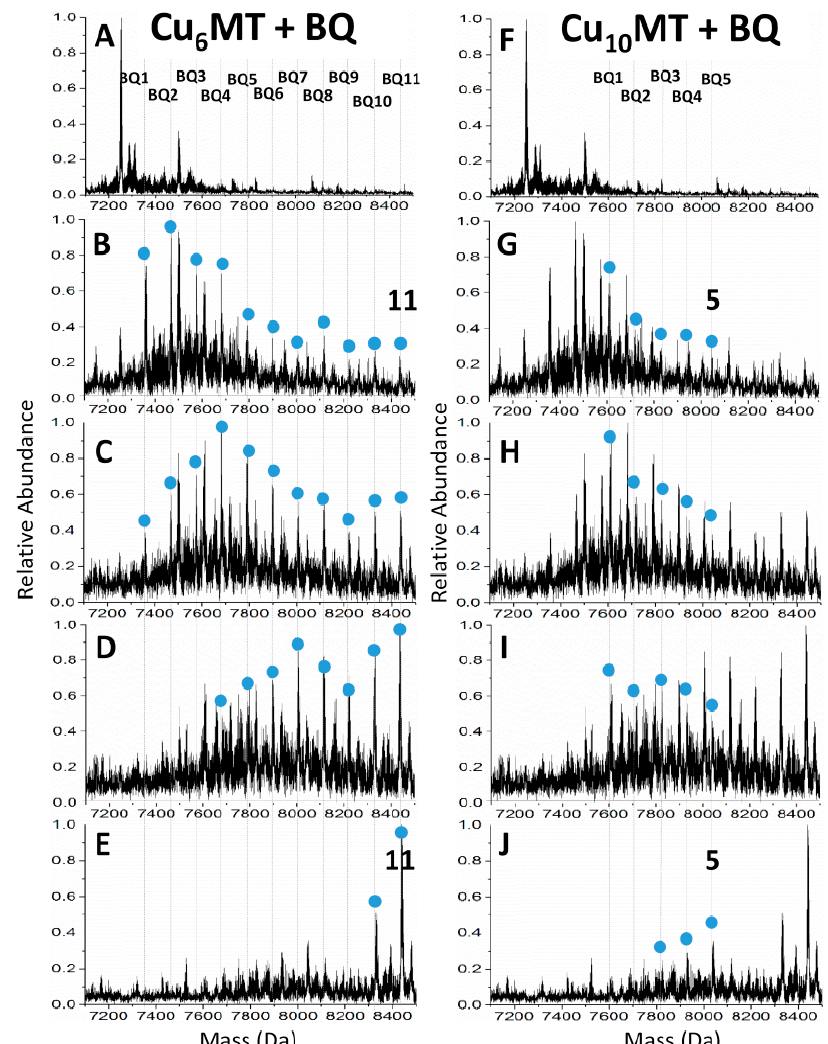
Figure 3. Free cysteine modification with p -benzoquinone of a Cu-MT solution containing mainly Cu 6 and Cu 10 -MT species. Both columns show the same spectra with different peaks labeled and highlighted with blue dots. Bq modified species for Cu 6 -MT are shown in ( A – E ) and the modified species for Cu 10 -MT are shown in ( F – J ). Reproduced from ref. [108] with permission from the Royal Society of Chemistry.